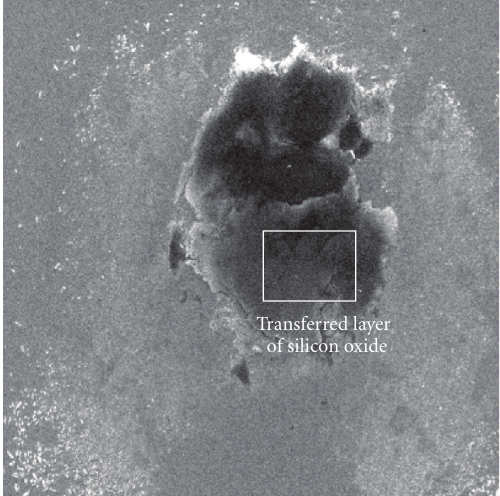
Figure 6: Transferred layer on SUS440C